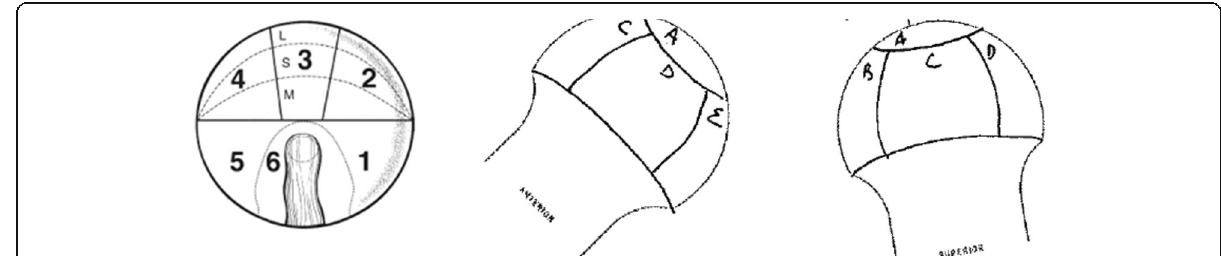
Fig. 3 Femoral Head Chondral Lesion Classification Systems. The right hip zones for the geographic (left) and Method G (right) methods. Reprinted from Arthroscopy, 24 (5), Ilizaliturri, V. M. et al., A geographic zone method to describe intra-articular pathology in hip arthroscopy: cadaveric study and preliminary report, 534 – 539, 2007, with permission from Elsevier